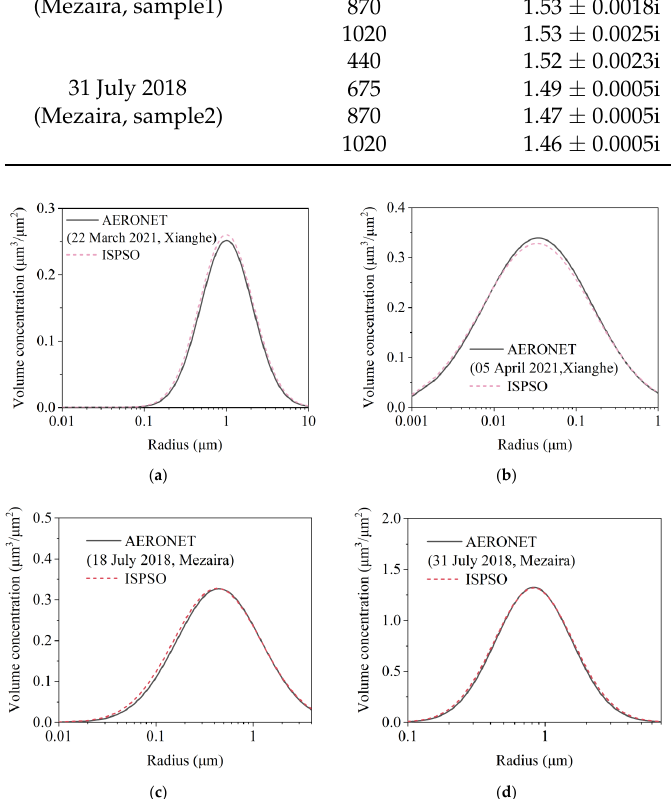
Figure 10. The application effect of the algorithm on real case: ( a ) dusty in Xianghe; ( b ) sunny in Xianghe; ( c ) sample1 in Mezaira; ( d ) sample2 in Mezaira.